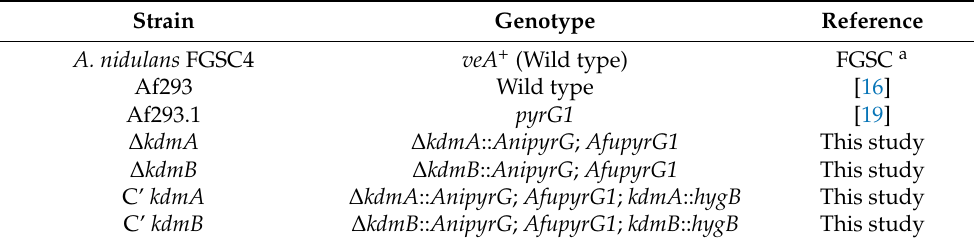
Table 1. Strains used in this study. Strain